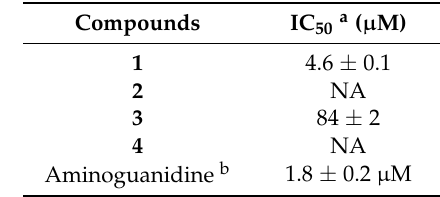
Table 3. Inhibitory activity of compounds on lipopolysaccharide (LPS)-induced nitric oxide (NO) production in RAW 264.7